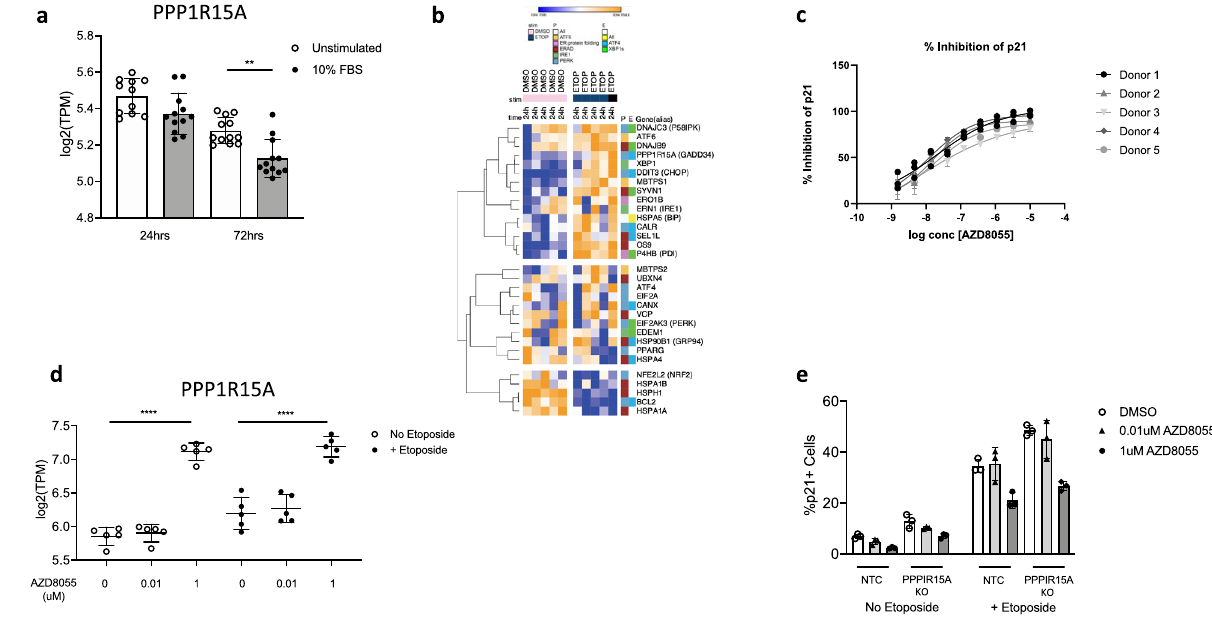
Figure 7. Etoposide-induced senescence in IPF lung fibroblasts is inhibited by the mTOR inhibitor AZD8055. ( a ) Expression of PPP1R15A in NHLF 24 h and 74 h after stimulation with 10% FBS. ( b ) Heatmap of gene expression [log2(TPM)] of the UPR genes from Table S1 for IPF fibroblasts (5 donors) treated with etoposide (3 µM) for 24 h. The genes are further colour coded into pathway (P) and expression regulators (E) according to Table S1. Top panel are genes induced by etoposide including PPP1R15A, bottom panel are genes suppressed by etoposide. ( c ) Dose–response curves for AZD8055. IPF fibroblasts were cultured in the presence of etoposide (3 µM) and with the indicated compound concentrations for 72 h, after which the cells were stained with an anti-p21 antibody as well as the cell and nucleus stains CellMask and Hoechst. The cells were imaged and the p21 inhibition percentage with AZD8055 was determined using image analysis. ( d ) Gene expression of PPP1R15A in IPF fibroblasts in the presence or absence of etoposide plus AZD8055 for 24 h. n = 5 IPF donor cell lines with each dot representing a different donor in each condition. ( e ) Etoposide-induced senescence was quantified between PPP1R15A KOs and wild-type (non-transfected control: NTC) cells. Cells were treated with AZD8055 (0.01 μM or 1 μM) and etoposide (3 μM) for 72 h. Senescence quantification was measured by immunofluorescence of nuclear p21 and represented as percentage p21 positive cells. Data is expressed as mean ± s.e.m. FDR adjusted P-values are show on plots where significant, * P < 0.05, **** P <